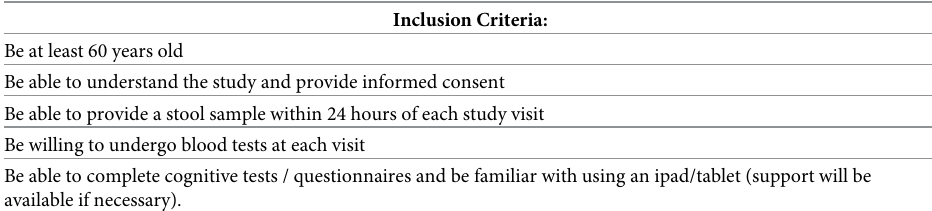
Table 1. MOTION study inclusion and exclusion criteria.